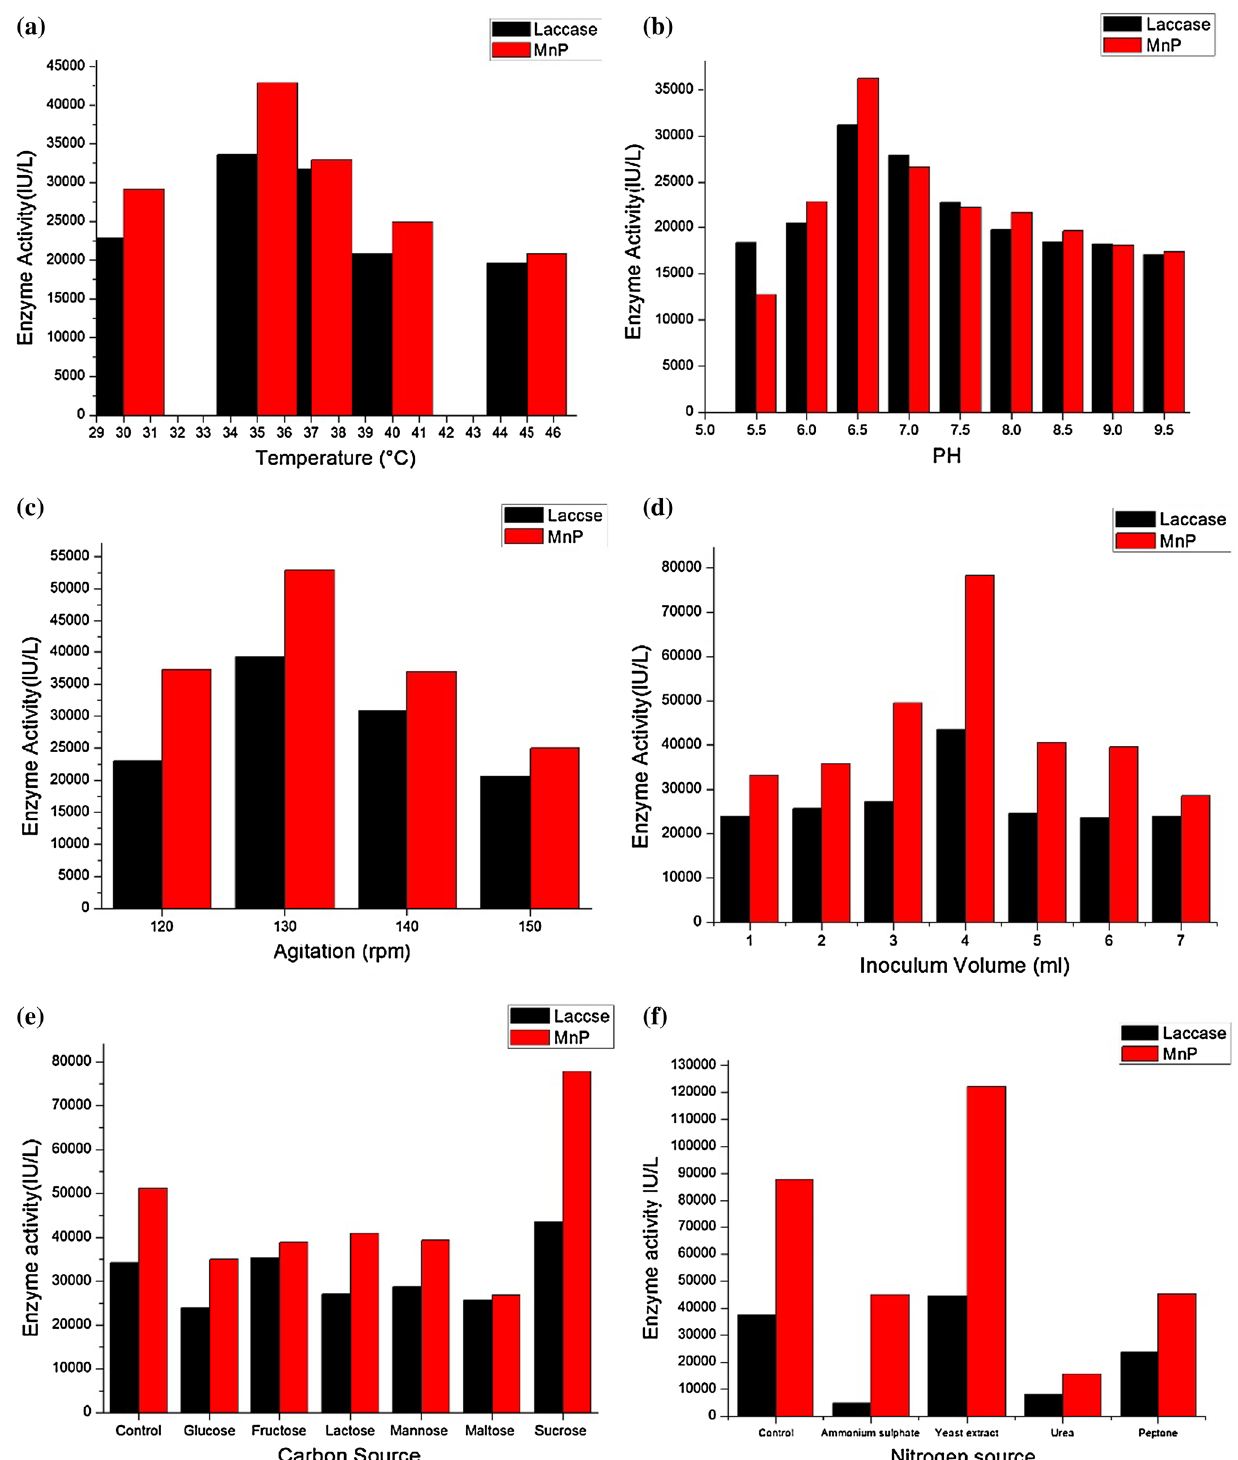
Fig. 2 Effect of a temperature, b pH, c agitation speed, d inoculum volume, e carbon source and f nitrogen source on laccase and MnP for Kleb- siella pneumoniae strain NITW715076_2, values are mean ± SE, n =